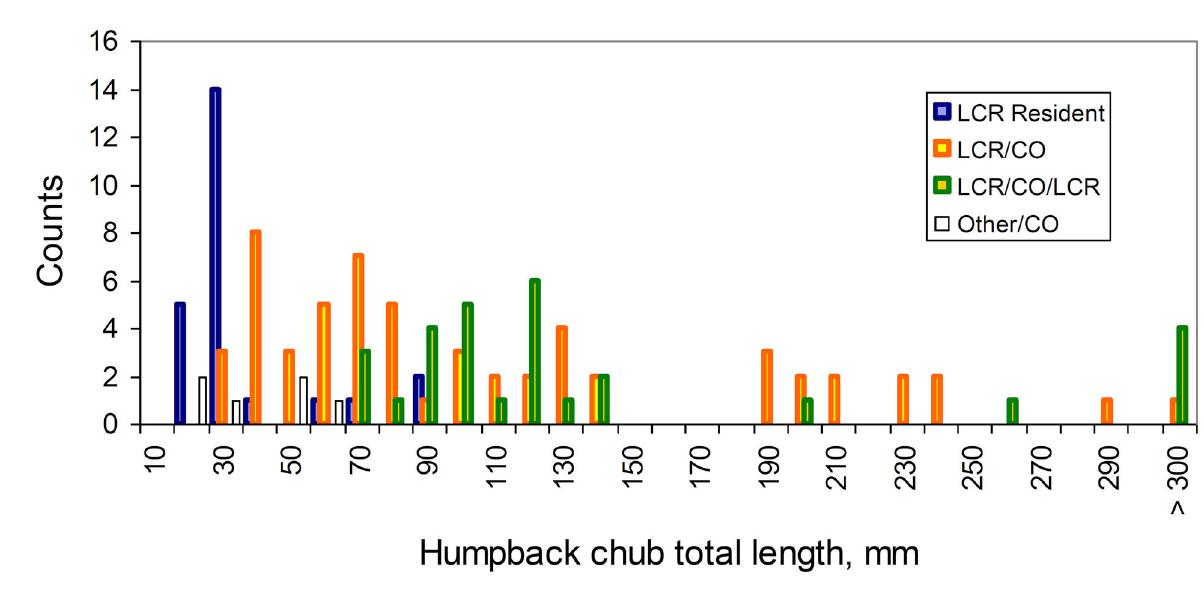
Figure 10. Number of humpback chub (y-axis) by size (x-axis) demonstrating specific residency patterns as determined from otolith microchemistry or growth analyses. “LCR Resident” are fish that were born in the Little Colorado River and were captured there. “LCR/CO” are fish that were born in the Little Colorado River and then emigrated to the Colorado River mainstem and were captured there. “LCR/CO/LCR” are fish that emigrated into the mainstem but were re-captured in the Little Colorado River. Finally, “Other/CO” are fish that were born in an unknown location, but then determined to be living in the Colorado River mainstem.